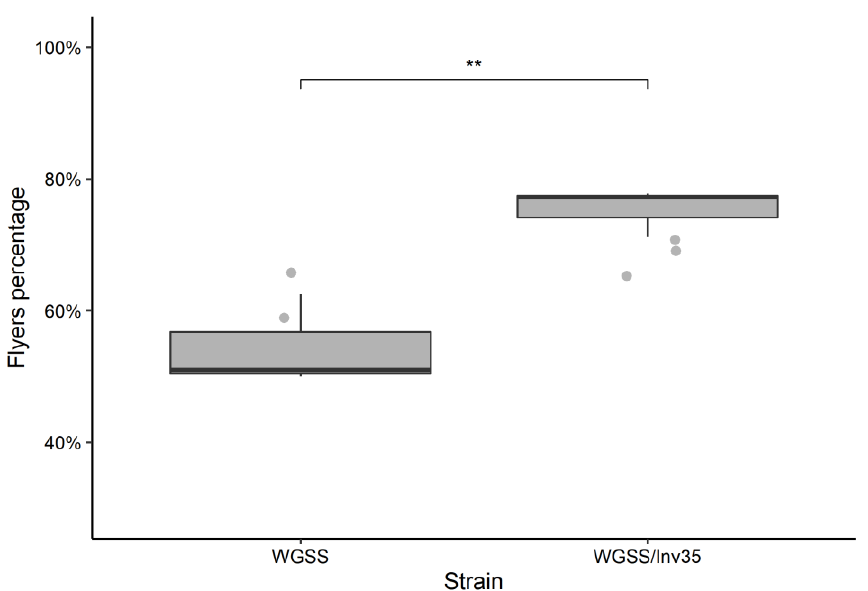
Figure 8. Flight ability of WGSS and WGSS/Inv35 males. Three replicates were performed per strain. Statistical analysis was carried out using a GLM with binomial distribution and showed significant difference between the strains. The whiskers indicate the variability outside the upper and lower quartiles (represented as the upper and lower boxes, respectively). The thick horizontal line represents the median. Significance symbol: ‘**’ for p value less than 0.01.